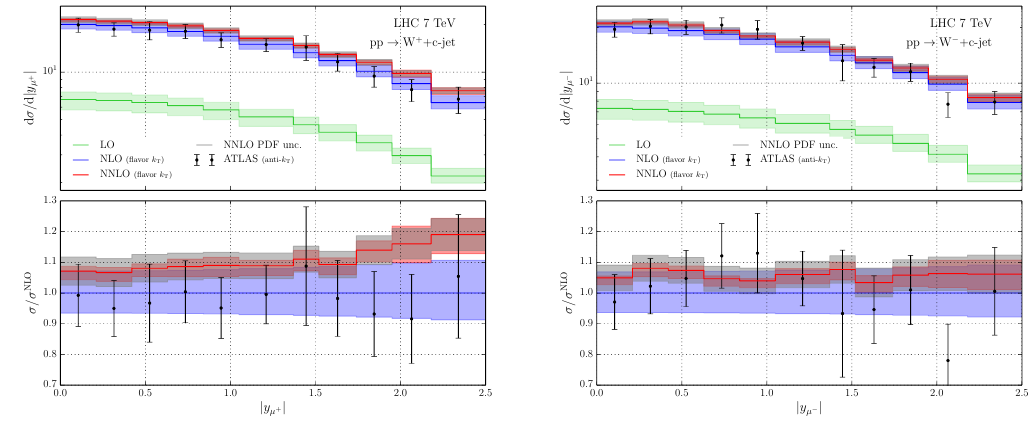
Figure 2: Cross sections for pp → W + j (cid:112) s = 7TeV. The theoretical predictions up to NNLO QCD accuracy are LHC with compared to the ATLAS data [ 3 ] .